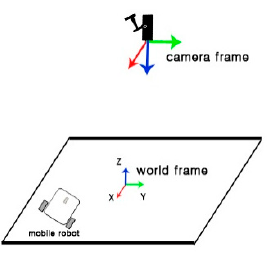
Figure 21. Illustration of camera pose and target pose.